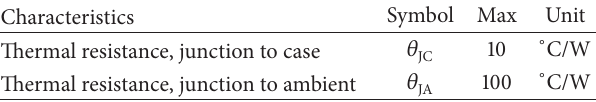
Table 1: Technical specifications of FLIR SC 620 infrared camera. Table 2: Thermal characteristics of MOSFET BD 135.